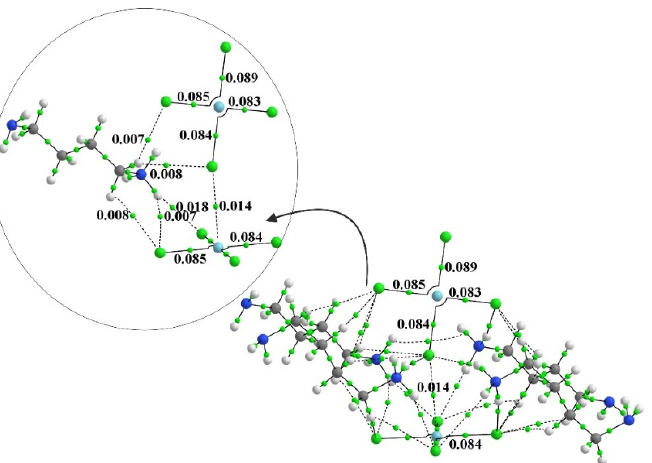
Figure 3. The AIM diagram of [NH 3 -(CH 2 ) 4 -NH 2 ] 4 [PdCl 4 ] 2 . Numbers refer to bond path critical point in au.